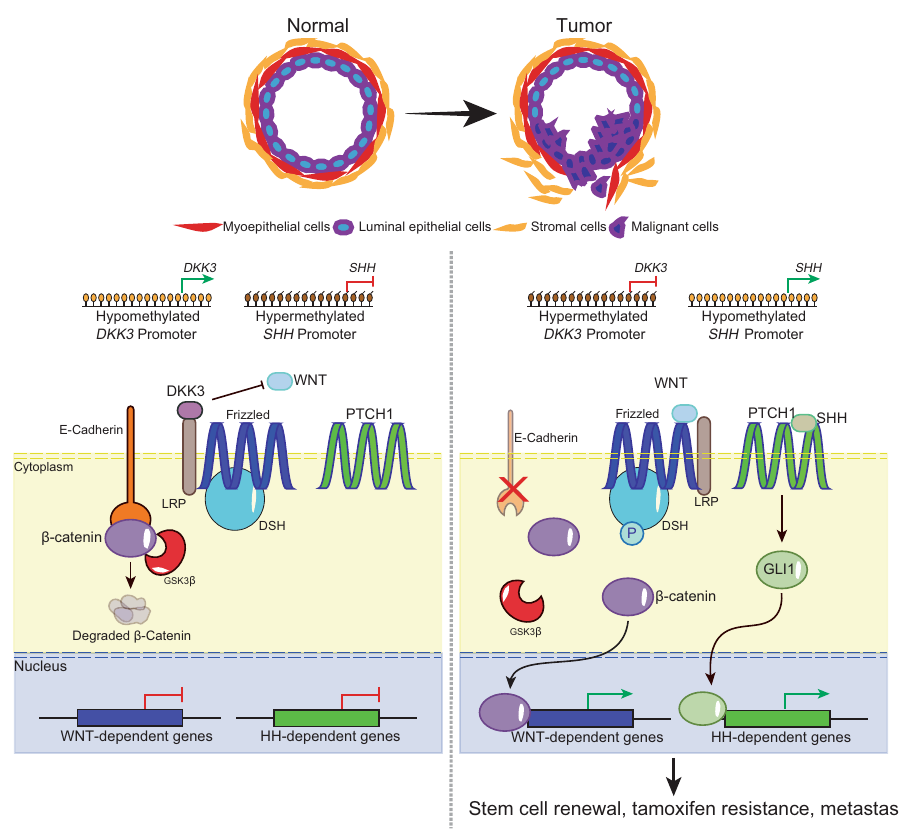
Fig. 2 The development of embryonic mammary glands is dependent on carefully coordinated spatial-temporal activation of signaling pathways such as WNT and Hedgehog (SHH). In normal mammary epithelium, DKK3 binds to LRP, a WNT pathway coactivator of Frizzled, which prevents the activation of the pathway in the presence of the WNT ligand. E-Cadherin binds to cytoplasmic β -catenin, which is degraded by GSK3 β in the absence of WNT activation. The promoter of SHH (encoding the Hedgehog ligand SHH) is hypermethylated and the Hedgehog pathway is silenced. In breast cancer, however, the DKK3 promoter is hypermethylated, which leads to its downregulation. In the absence of DKK3, LRP can coactivate Frizzled in the presence of the WNT ligand, leading to phosphorylation of DSH, which inhibits GSK3 β from degrading β -catenin. E-Cadherin is also downregulated via promoter methylation. In addition, the SHH promoter becomes hypomethylated, thereby upregulating the expression of SHH and activating the Hedgehog pathway via GLI1. Activation of the WNT and the Hedgehog pathways lead to stem cell renewal, EMT, metastasis, and tamoxifen